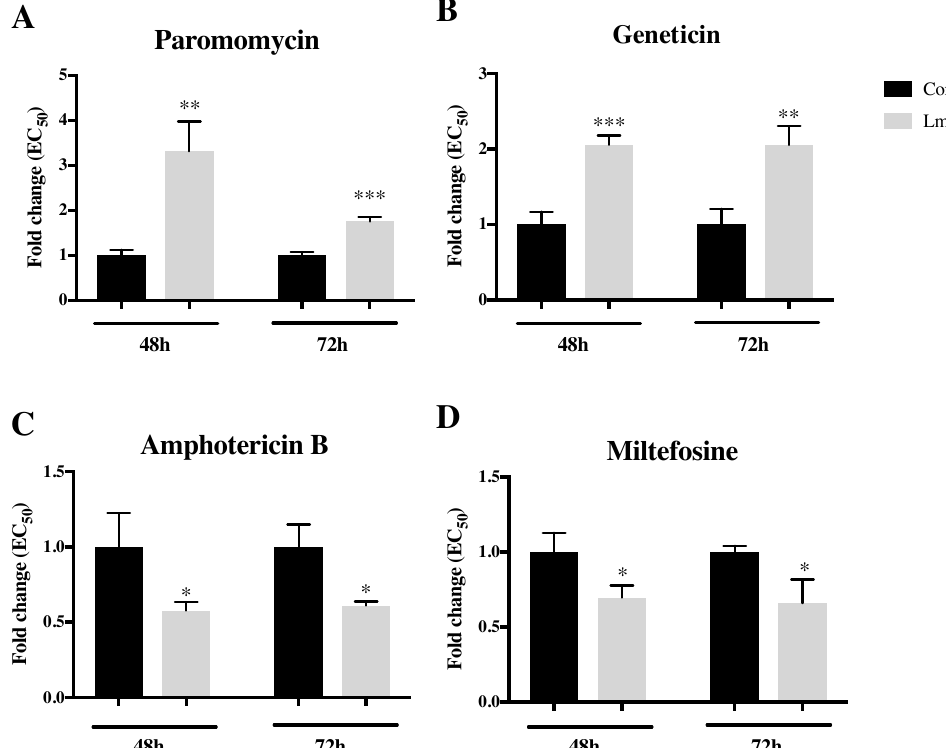
Figure 9. LmJean3-overexpression in Leishmania (LmJ3OE parasites) reduced the sensitivity to AG treatment after 48 h and 72 h. Leishmanicidal activity determination (EC 50 ) by MTT assays of ( A ) paromomycin, ( B ) geneticin (G418), ( C ) amphotericin B, and ( D ) miltefosine in (mock) control and LmJ3OE parasites. Bars represent the normalized mean EC 50 ( ± SD) from three independent experiments (* p < 0.05, ** p < 0.01, *** p <